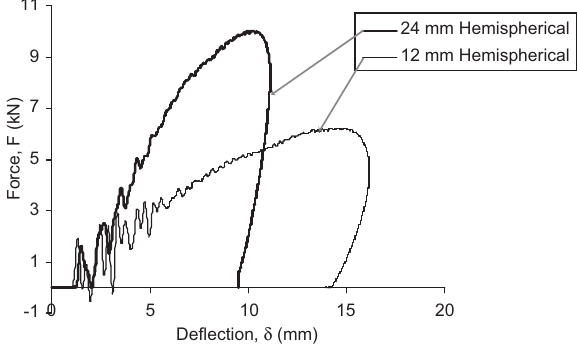
Figure 6 Force-defl ection curves for the hemispherical impactors.